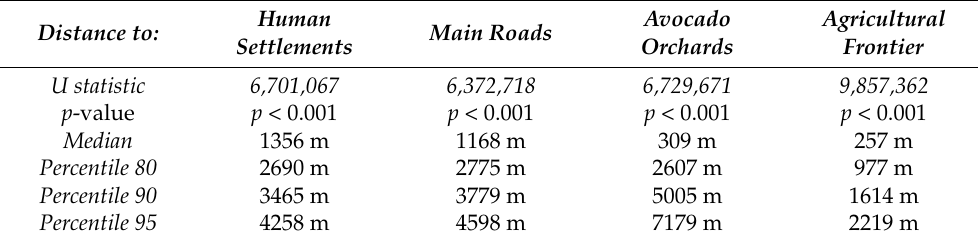
Table 3. Distance and significance of the social drivers of ignitions on the MAB. Avocado Agricultural Human Main Roads Distance to: Orchards Frontier Settlements U statistic 6,701,067 6,372,718 6,729,671 9,857,362 p